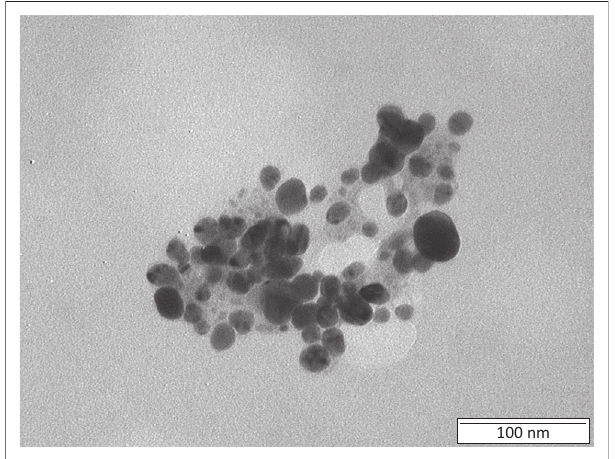
FIGURE 4: Transmission electron microscopy micrograph of silver nanoparticles synthesised using leaf extract of Cannabis sativa (Scale 200 nm at 200 kV).